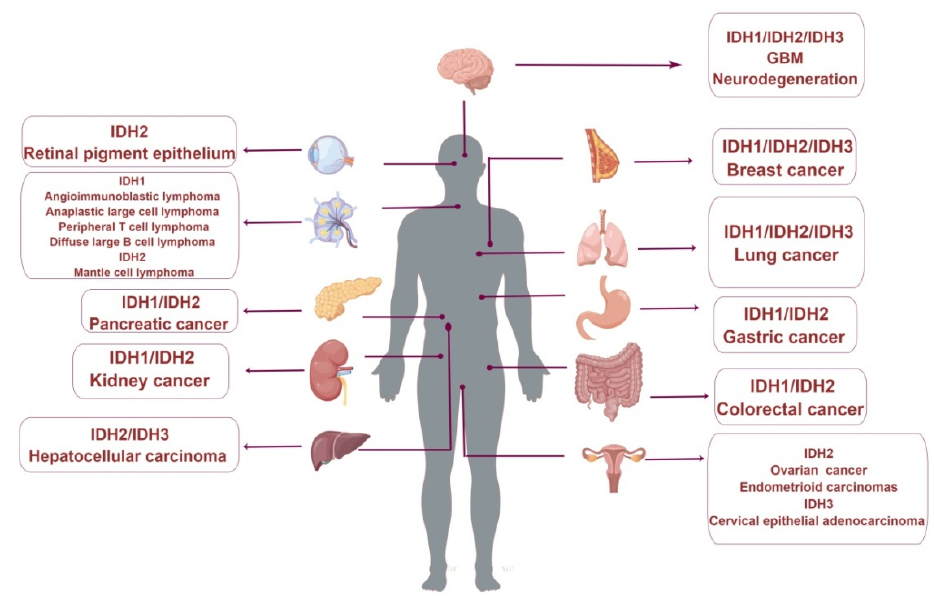
Figure 3. Changes in wild-type IDH expression are associated with human diseases. (By